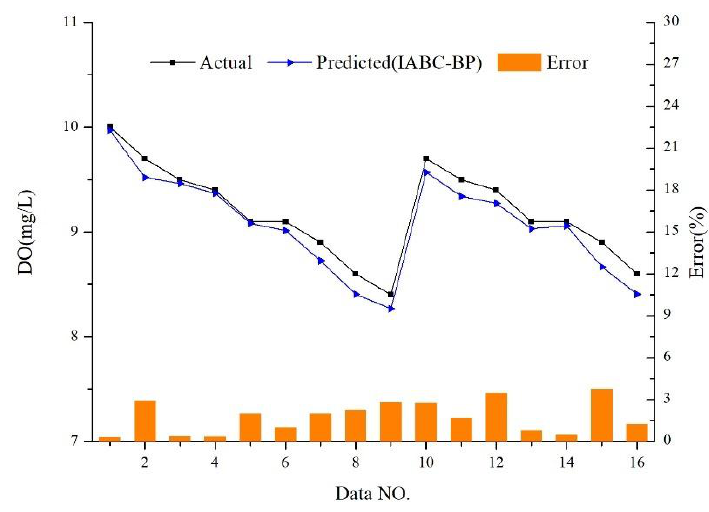
Figure 13. The predicted IABC-BP value and its error percentage.